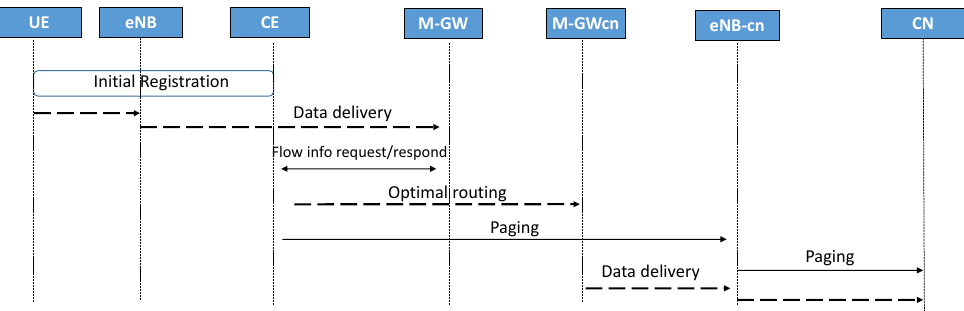
Figure 5. The data delivery procedure from Mobile host to Mobile host in the proposed 5G